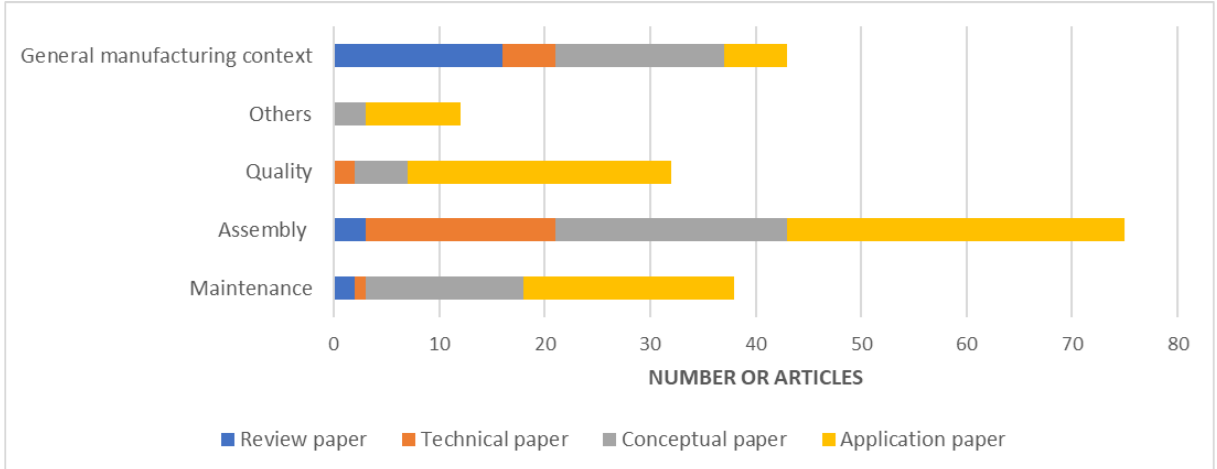
Figure 5. Type of papers and application field.